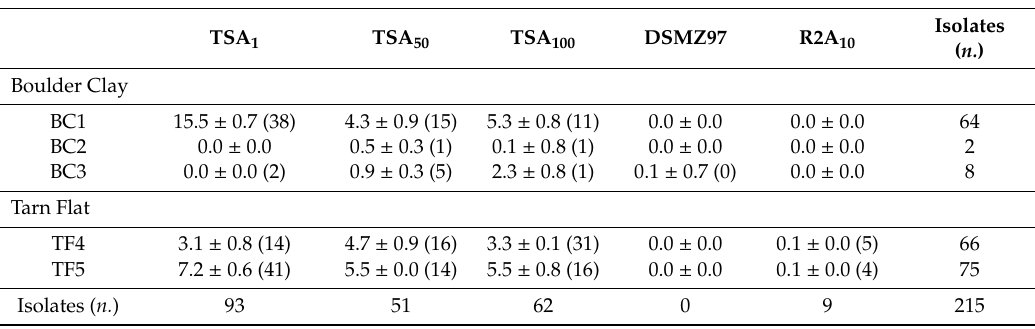
Table 1. Boulder Clay and Tarn Flat viable counts (CFU mL − 1 × 10 3 ) and number of isolates (in brackets) obtained from direct plating per sample and isolation medium. Viable Counts (Number of Isolates) on Di ff erent Culture Media 1